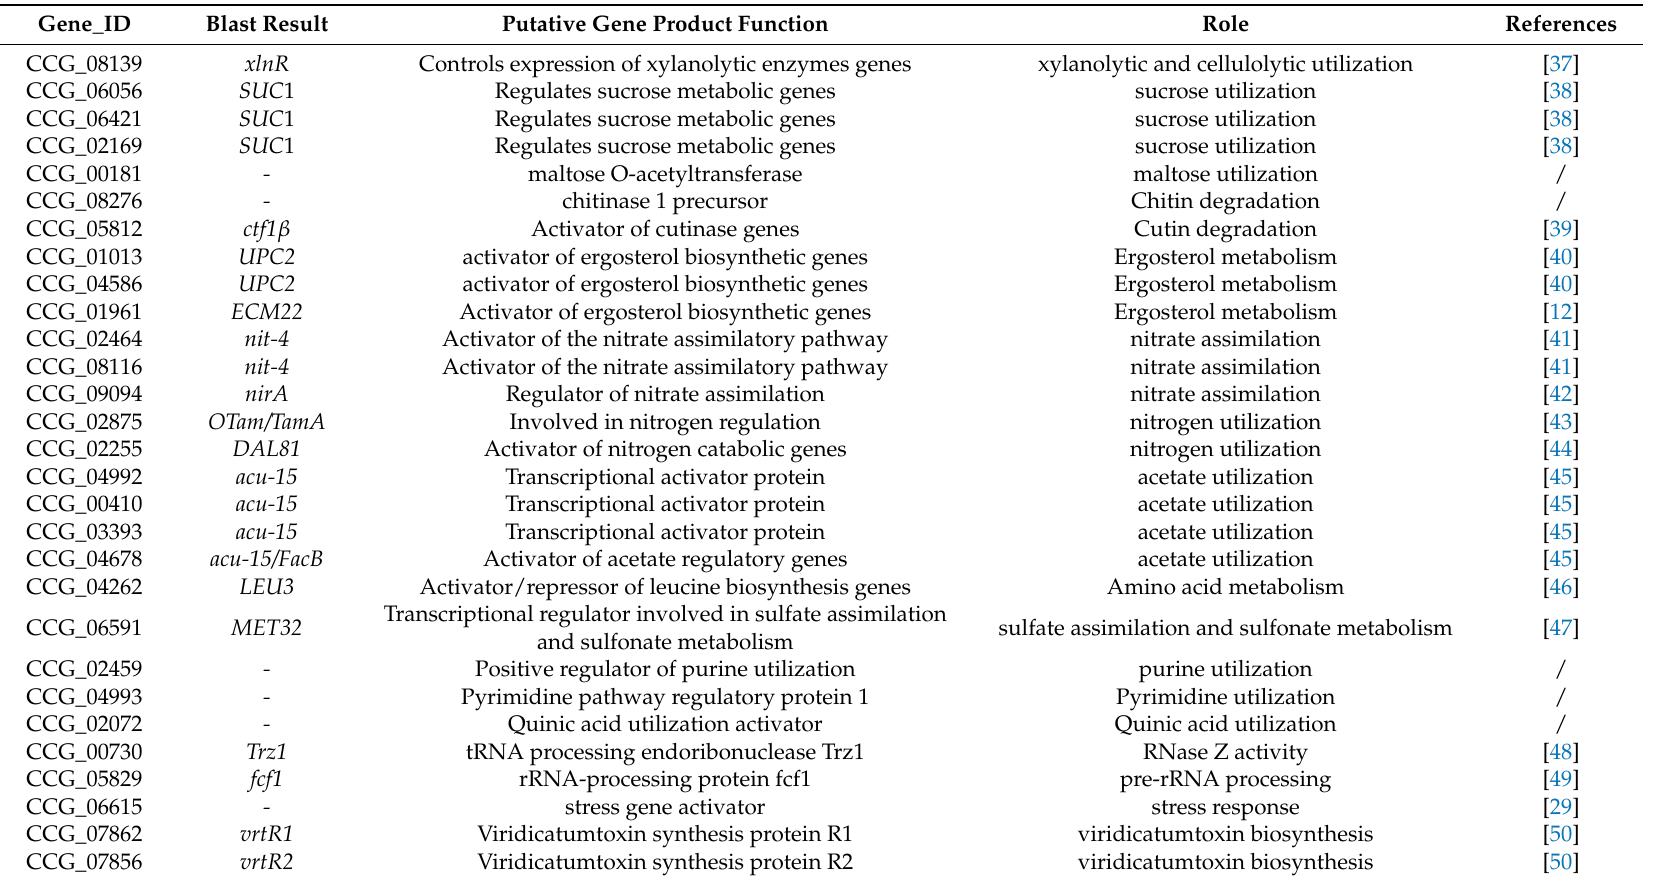
Table 2. Homologous analysis of C6 zinc proteins with the metabolic process in T. guangdongense